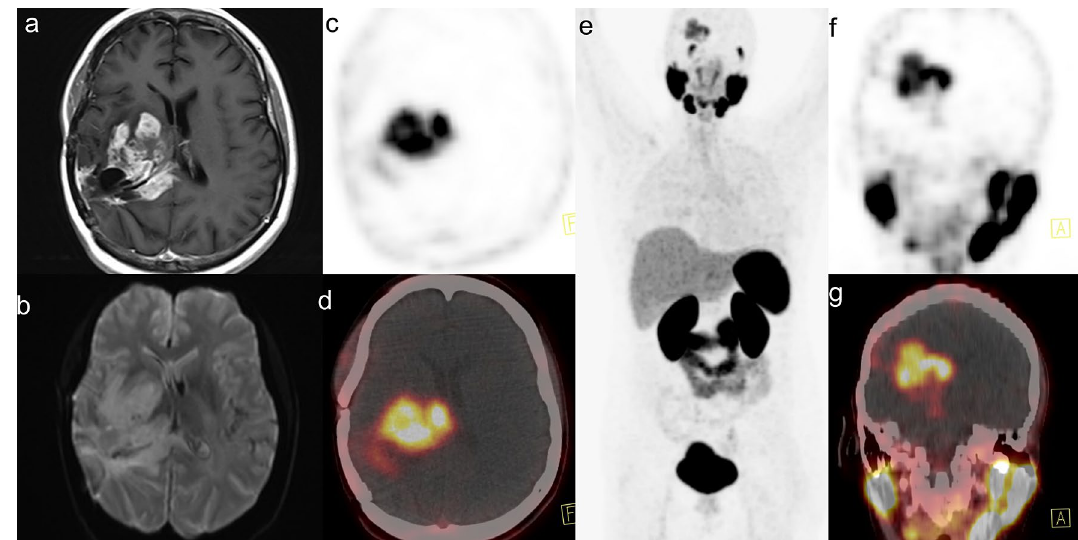
Figure 1. Male, 39 years, with a recurrent anaplastic astrocytoma IDH wildtype grade III in the right parieto- occipital lobe. Three years after surgery, and 15 months after local radionuclide therapy with [ 213 Bi]Bi-DOTA-SP, a contrast-enhanced mass around the surgical cavity was detected with MR. [ 68 Ga]Ga-PSMA-11 accumulation in the tumor was found with the SUV max 4.9, SUV mean 3.3, TBR 70 and TLR 0.8 ( a —contrast-enhanced T1WI, b —DWI, c —PET transverse image, d —fused PET/CT transverse image, e —maximal intensity projection, f — PET sagittal image, g —fused PET/CT sagittal image).